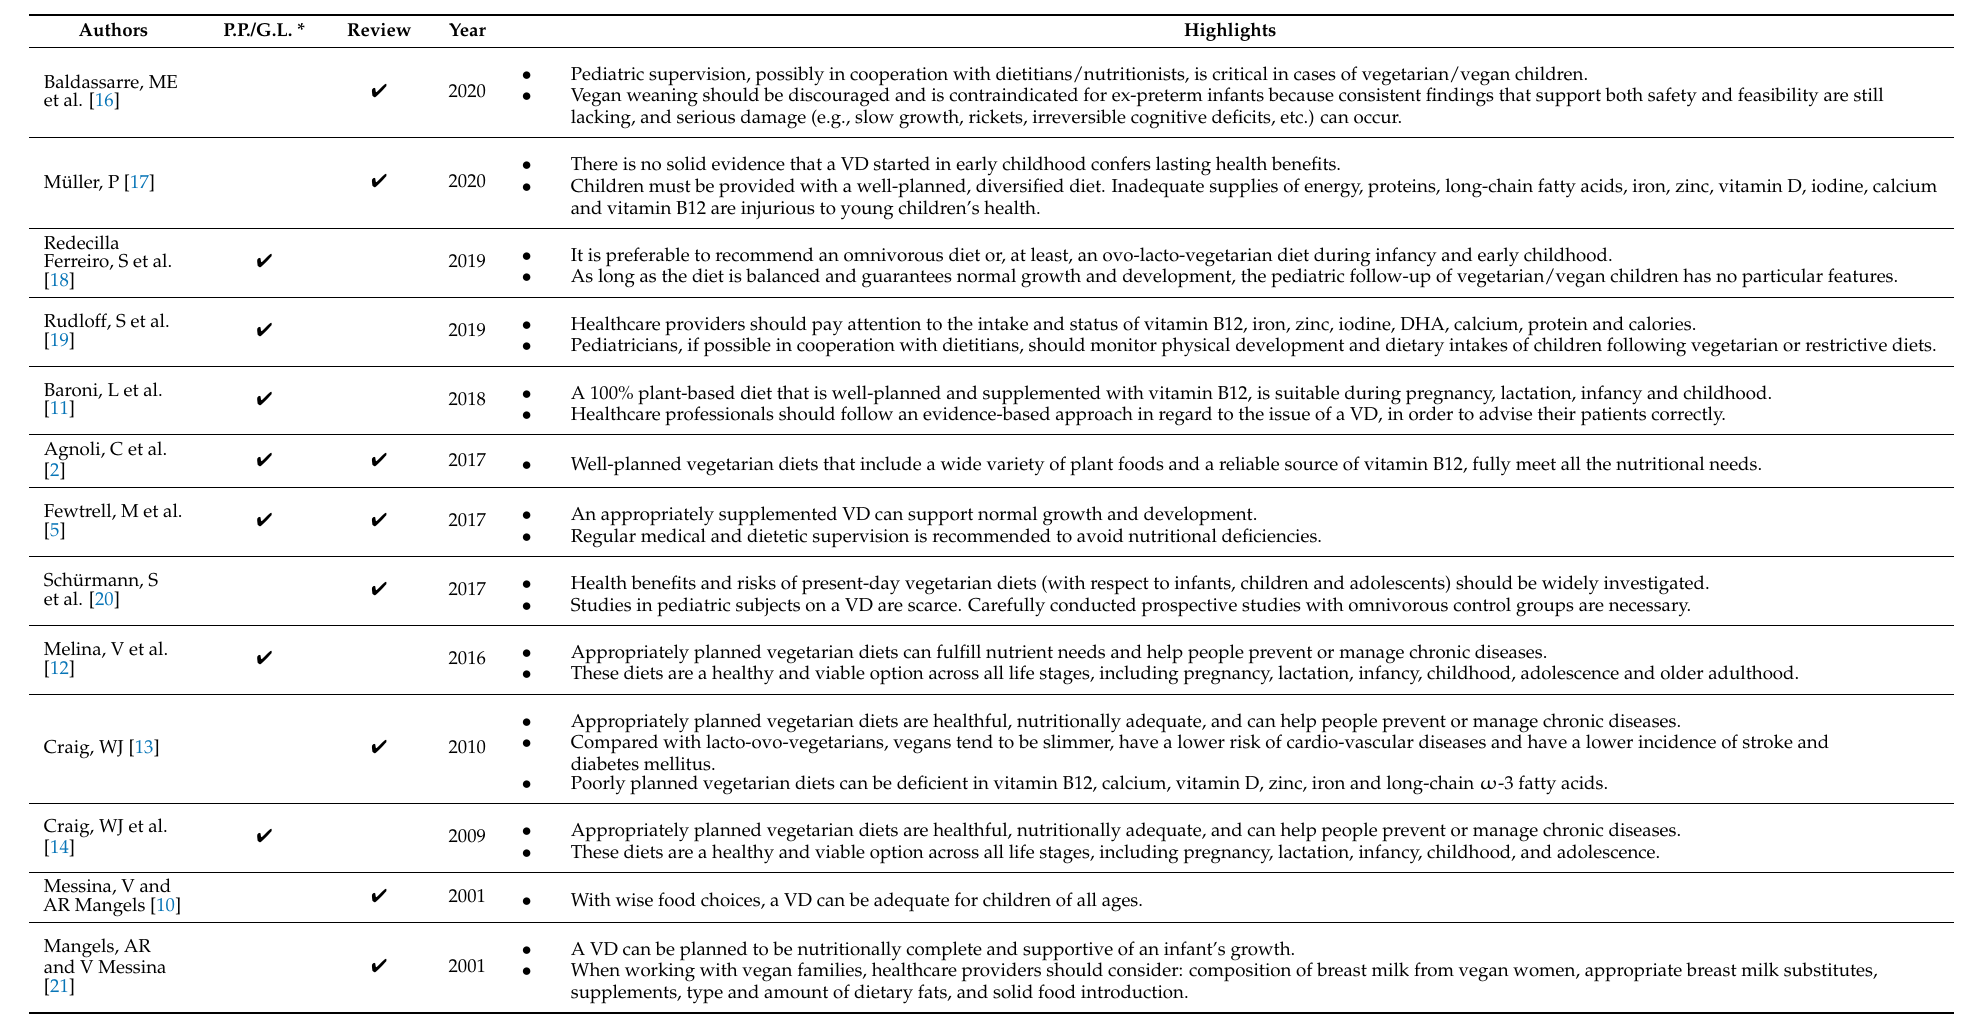
Table 1. Position Paper, Guidelines and Reviews on VD during infancy and